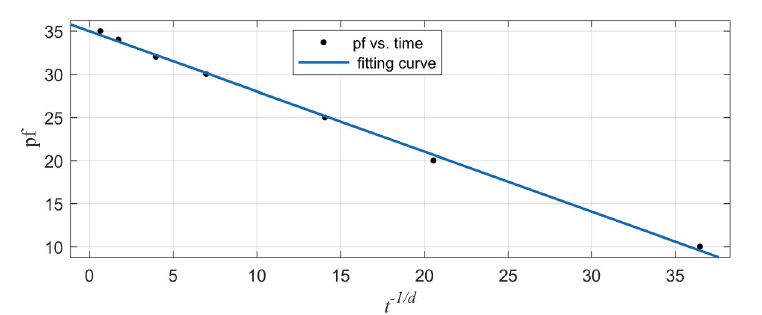
Figure 1. Fitting of the packing fraction by Eq.